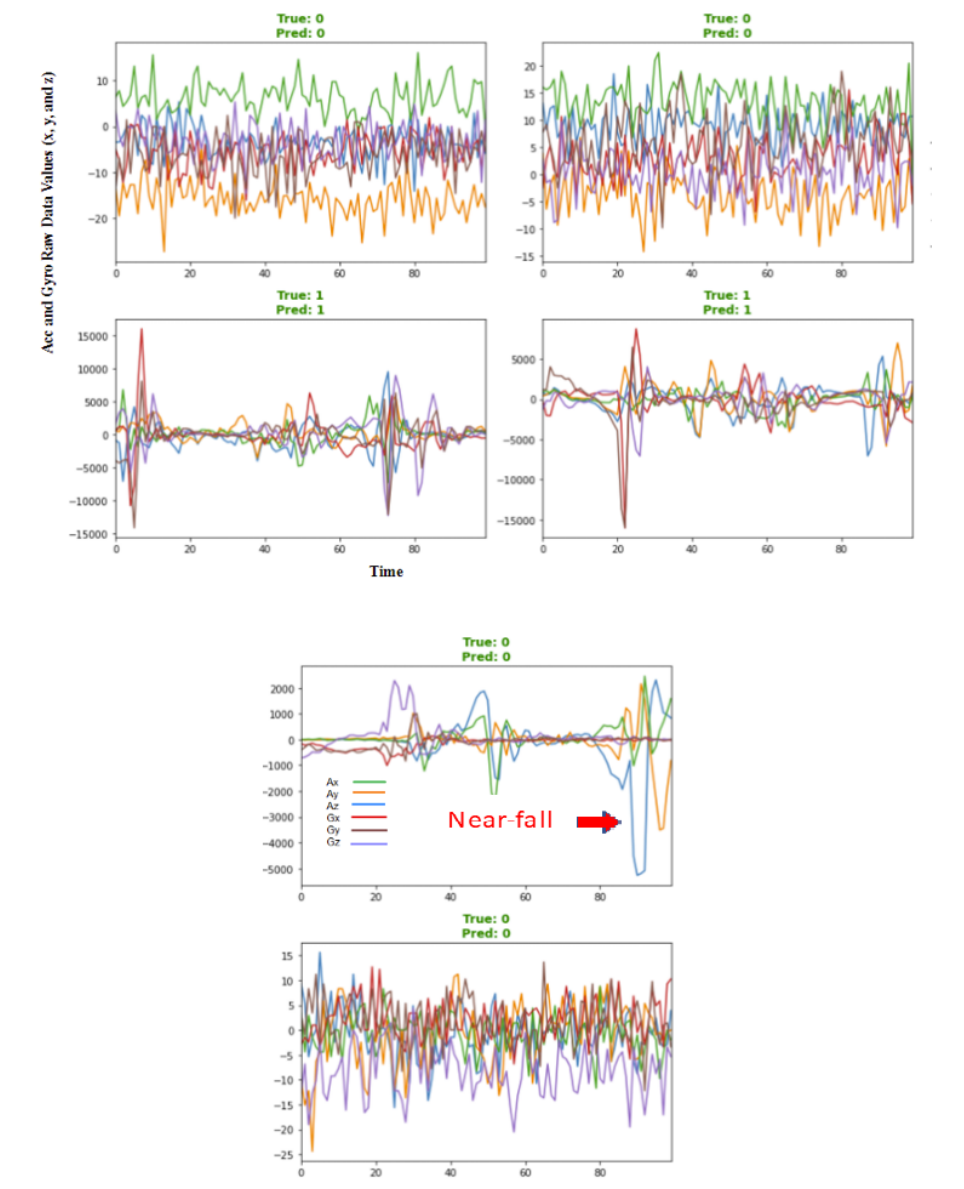
Figure 5. Sample predicted classes using the LSTM encoder-based model. Non-fall activity (class 0), fall activity (class 1), and True, Pred are the actual and predicted classes,